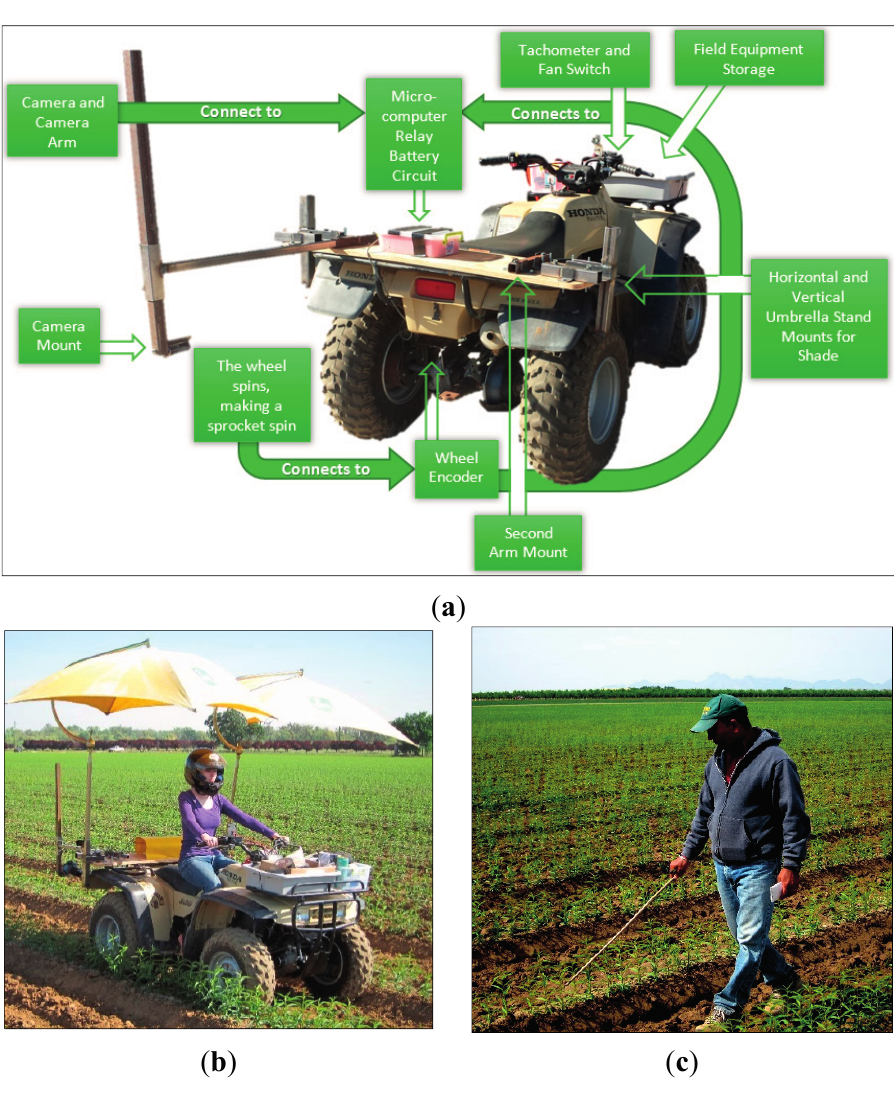
Figure 2. ( a ) The ATV with an arm to mount the camera, the wheel encoder, and the microcontroller to activate the camera via a relay; ( b ) the vehicle in operation capturing pictures of plants; and ( c ) manual counting of plants by a staff person.